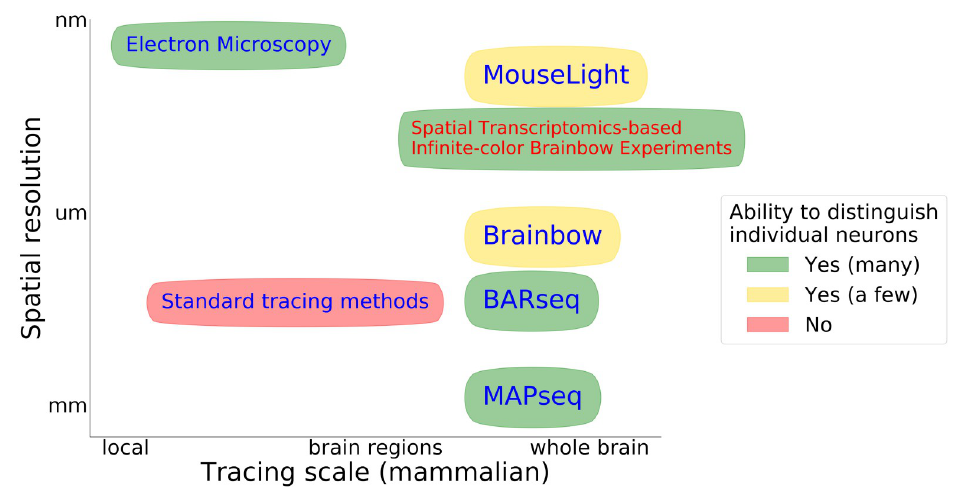
Fig 1. Some existing methods for neuronal morphology mapping. Here we non-exhaustively summarize the landscape of existing neuronal tracing methods. The horizontal axis indicates the typical scale of these neuronal tracing methods, ranging from local tracing to mapping axonal projections across the whole brain; the vertical axis indicates optical resolution in the typical images obtained from these methods. The ellipse color represents the number of neurons that can be traced and distinguished; red indicates that the method cannot readily distinguish between spatially nearby neurons, yellow indicates that the method can be used to trace several individual neurons, and green indicates the possibility of simultaneously mapping thousands or millions of neurons. Here ‘standard tracing methods’ refer to approaches such as Golgi staining and viral tracers; cf. Section 2 for more details. Note that many of these methods rely on conventional optical microscopes, and their resolution can potentially be increased via expansion microscopy and/or super resolution microscopy, though this may incur additional experimental costs. In this paper we focus on the possibility of extending molecular barcoding methods by increasing the signal density to allow for more fine-grained morphological reconstructions; we call such experiments Spatial Transcriptomics-based Infinite-color Brainbow Experiments